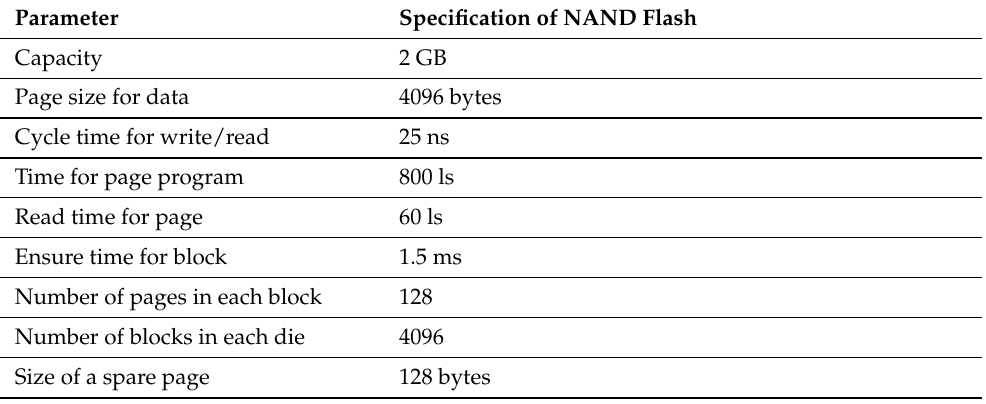
Table 2. Specifications and parameters of NAND flash.